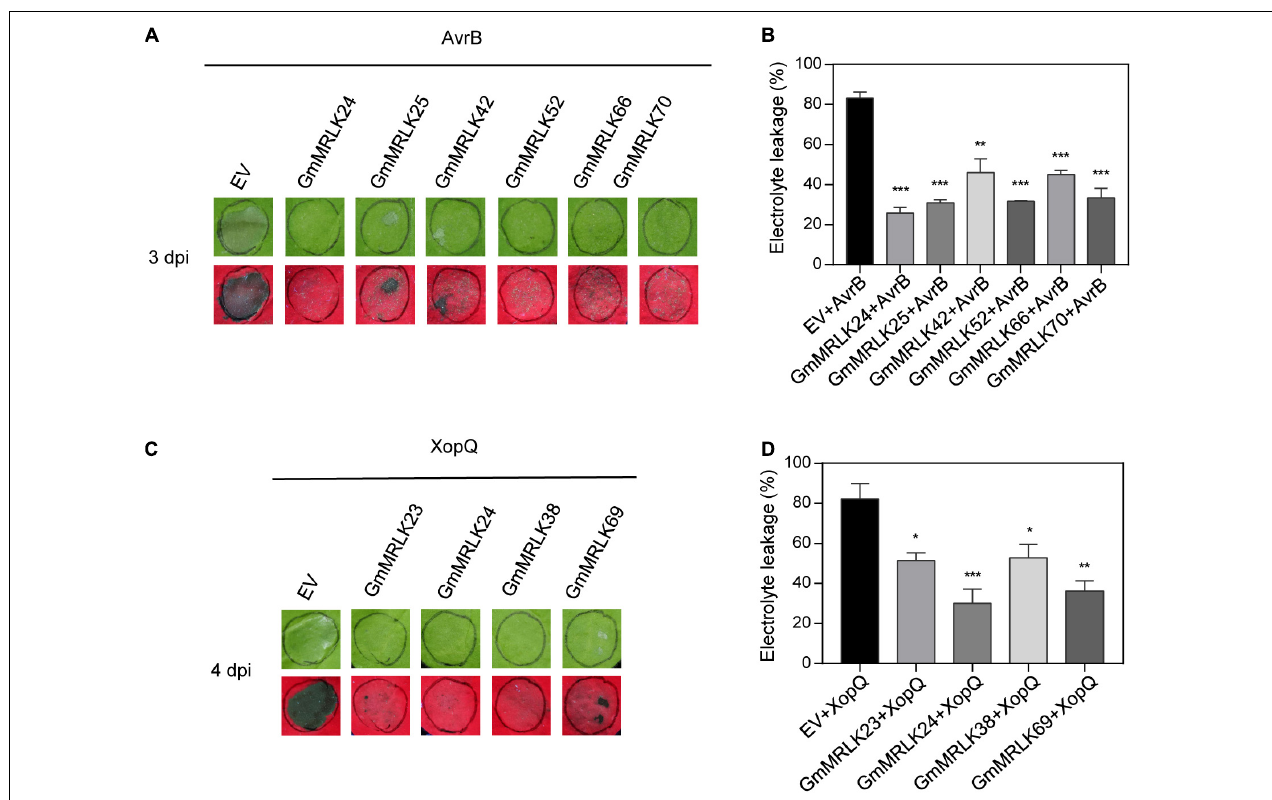
FIGURE 5 | GmMRLKs suppress AvrB and XopQ-induced HR reaction. (A,B) GmMRLKs suppress Pseudomonas syringae effector AvrB -induced HR. The indicated GmMRLKs were transiently expressed in N. benthamiana for 1 day, and infiltrated with Agrobacterium carrying AvrB. The cell death phenotype was examined by taking photograph under UV light (A) and measuring the electrolyte leakage (B) . (Mean ± SD, n ≥ 8, student’s t -test; ** p < 0.01, *** p < 0.001). (C,D) GmMRLKs suppress Xanthomonas campestris effector XopQ-induced HR. The indicated GmMRLKs were transiently expressed in N. benthamiana for 1 day, and infiltrated with Agrobacterium carrying XopQ. The cell death phenotype was examined by taking photograph under UV light (C) and measuring the electrolyte leakage (D) . (Mean ± SD, n ≥ 8, student’s t -test; * p < 0.05, ** p < 0.01, *** p <